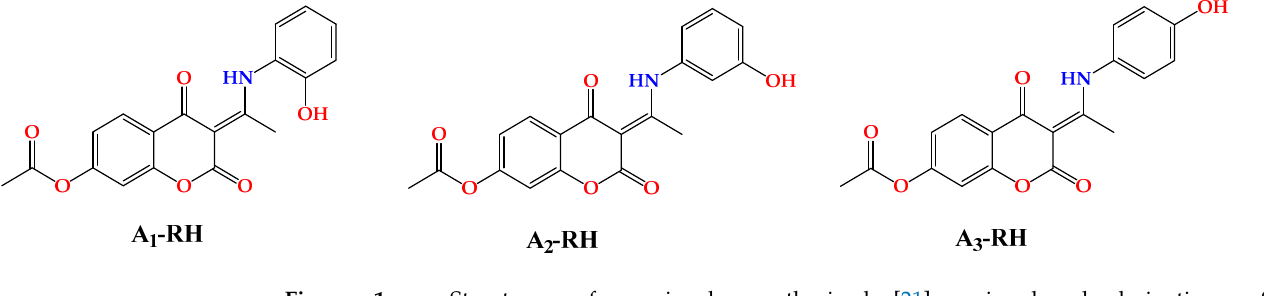
Figure 1. Structures of previously synthesized [21] aminophenol derivatives of 4,7 − dihydroxycoumarin. The applied methodology was based on the calculation of the thermodynamic and kinetic parameters of generally accepted radical scavenging mechanisms, such as hydro- gen atom transfer (HAT), single-electron transfer followed by proton transfer (SE − TPT), sequential proton loss followed by electron transfer (SPLET), and radical adduct formation (RAF) [25,26]. In addition, assessment of the reactivity of the newly formed radical species utilizing appropriate models for biomolecular targets was one of the main goals of this work, since one of the prerequisites for AOPs is the lower reactivity of final products. A theoretical prediction of the ecotoxicity of the formed products toward aquatic organ- isms was also calculated using available software resources. The obtained results for the title compounds, as model systems, represent a basis for future investigations into the degradation processes of different coumarin